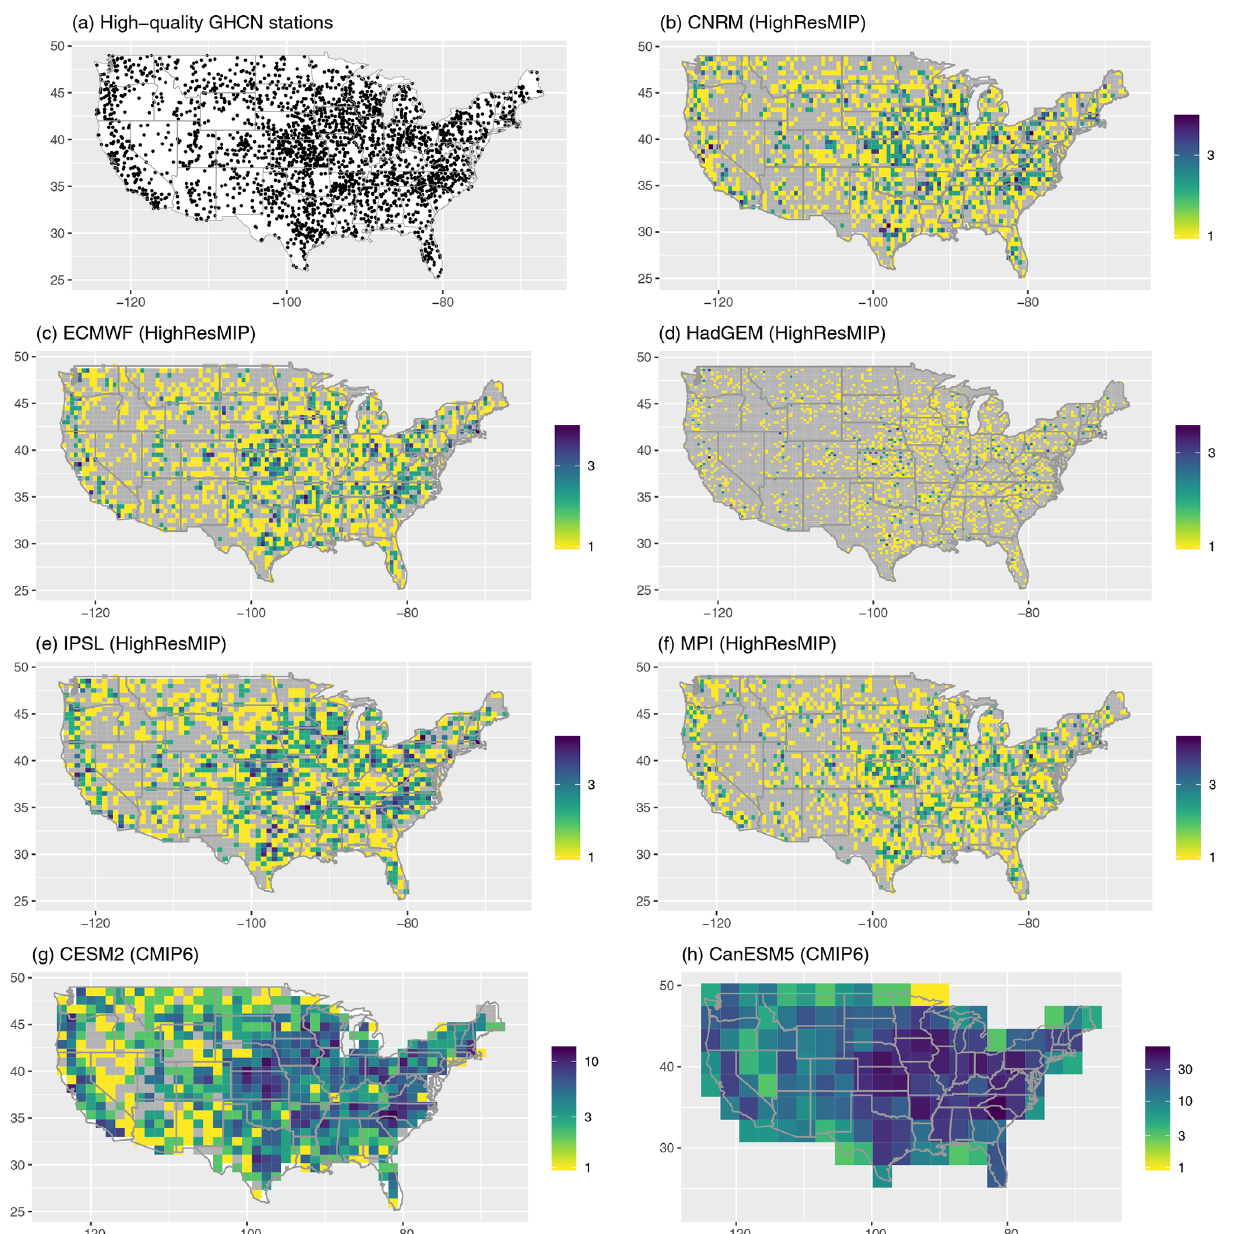
Figure A2. The geographic distribution of the high-quality GHCN stations considered in the analysis (a) , with the number of high-quality GHCN stations in each model grid cell for the HighResMIP models considered in this paper (b–f) and two CMIP6 models for comparison (g– h) . Model grid cells without a representative high-quality GHCN station are shown in